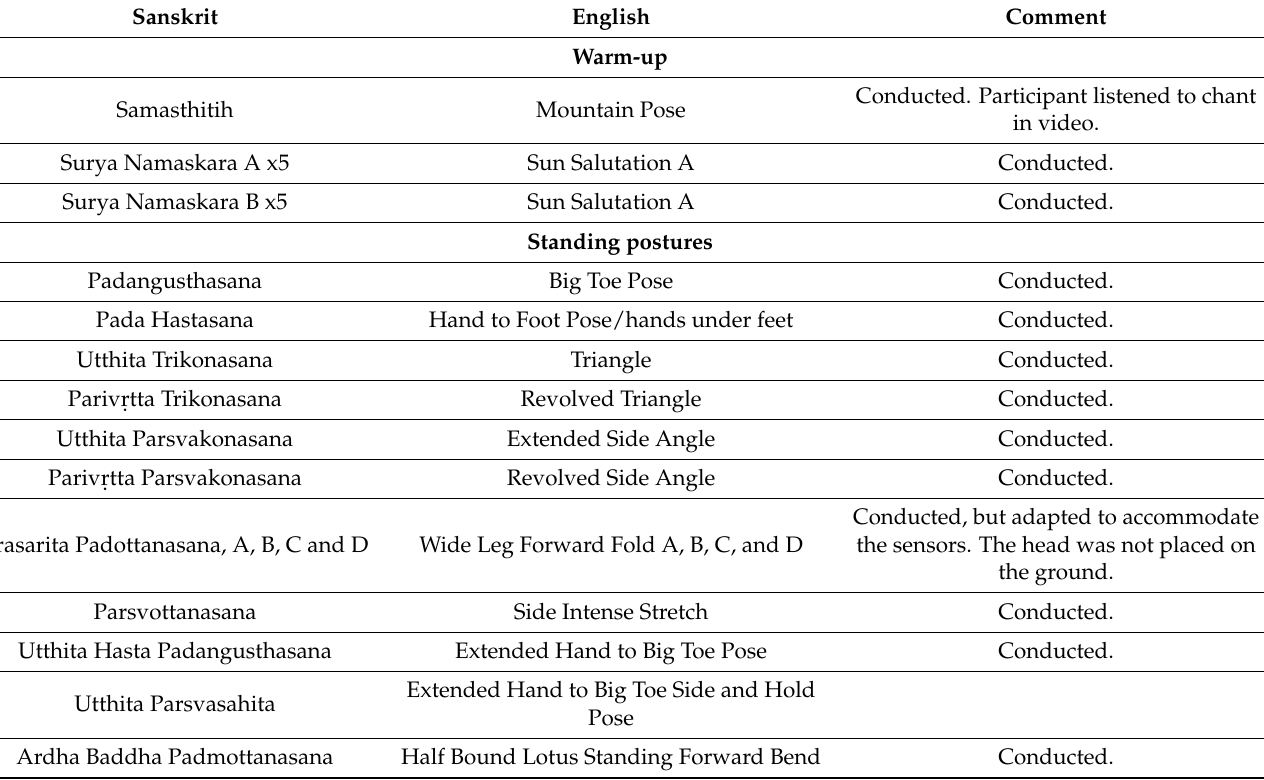
Table A1. Practice sheet/list of